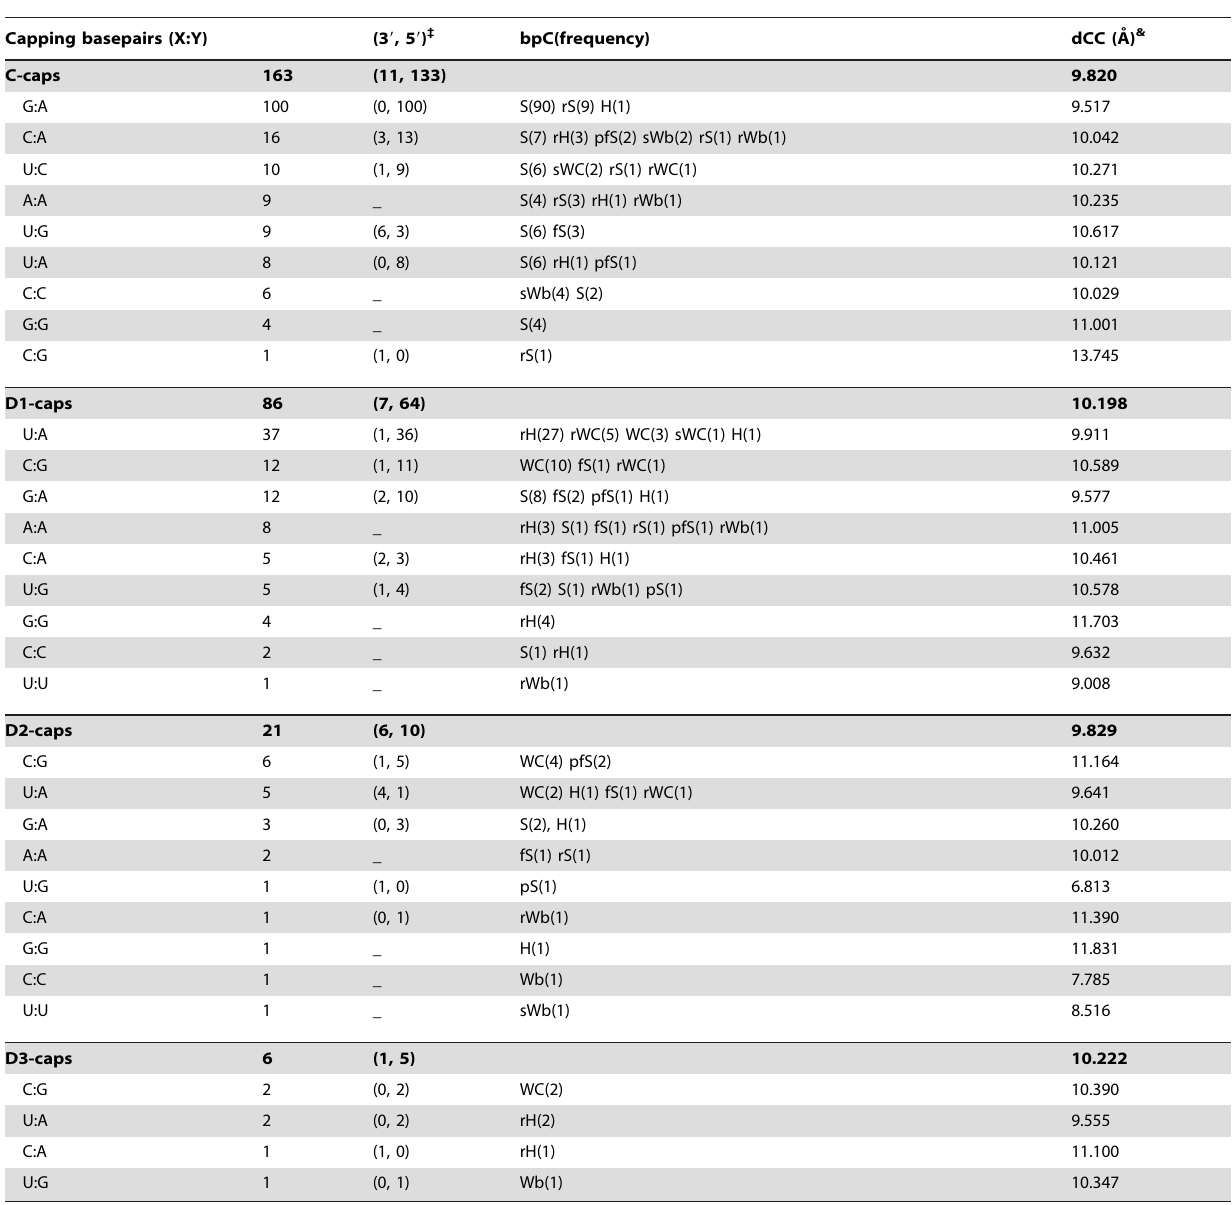
Table 1. Diversity of capping basepairs and their conformations (bpC) { and